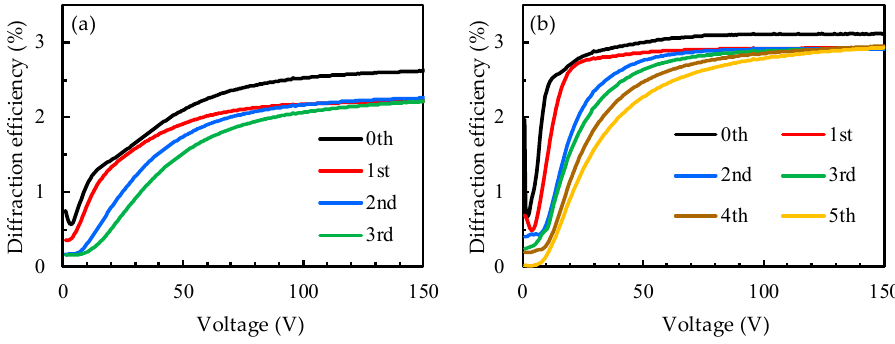
Figure 7. Diffraction efficiency of PDLC grating with cell gap of ( a ) 10 μ m and ( b ) 5 μ m.